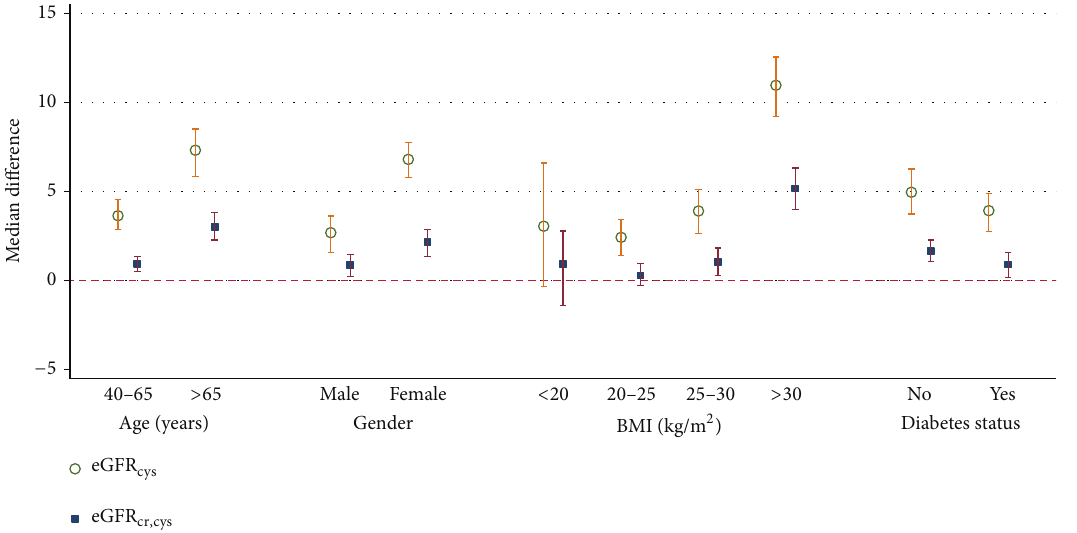
Figure 1: Performance of estimating equations by age, gender, BMI, and diabetes status. Referent equation: serum creatinine 2009 equation (age, sex, and race)